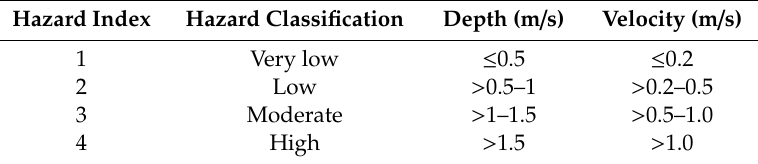
Figure 24. Water level profiles for the wave of maximum flow for case B1.